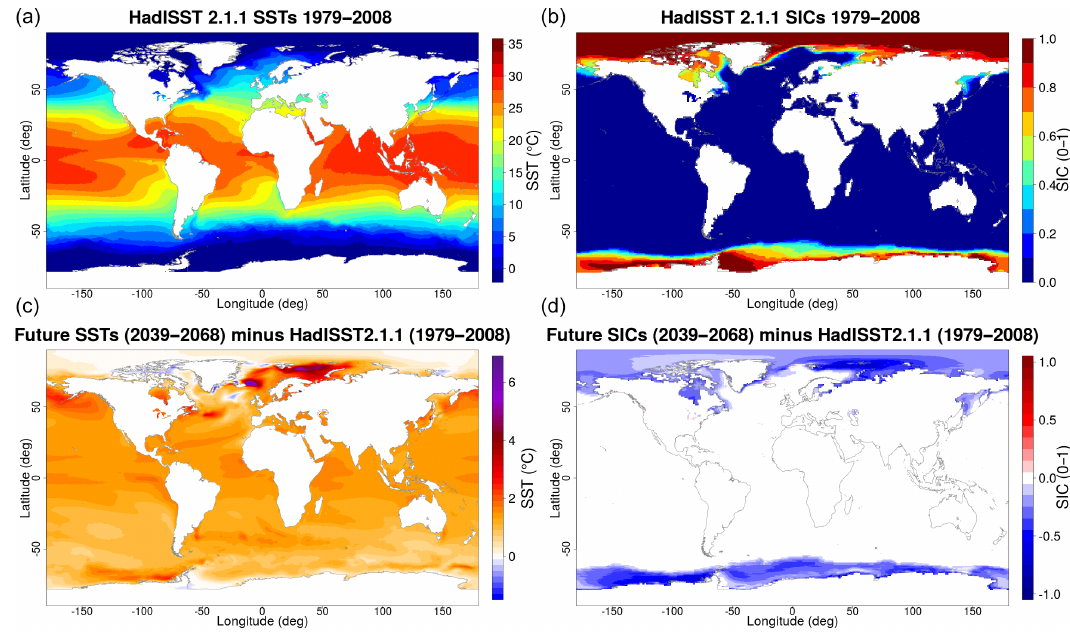
Figure 1. (a, b) HadISST 2.1.1 climatology for the SSTs (a) and SIC (b) for the 1979–2008 period. (c, d) Climatological changes between the FutureHadISST 2.1.1 dataset and the HadISST 2.1.1 dataset for SST (c) and SIC (d)